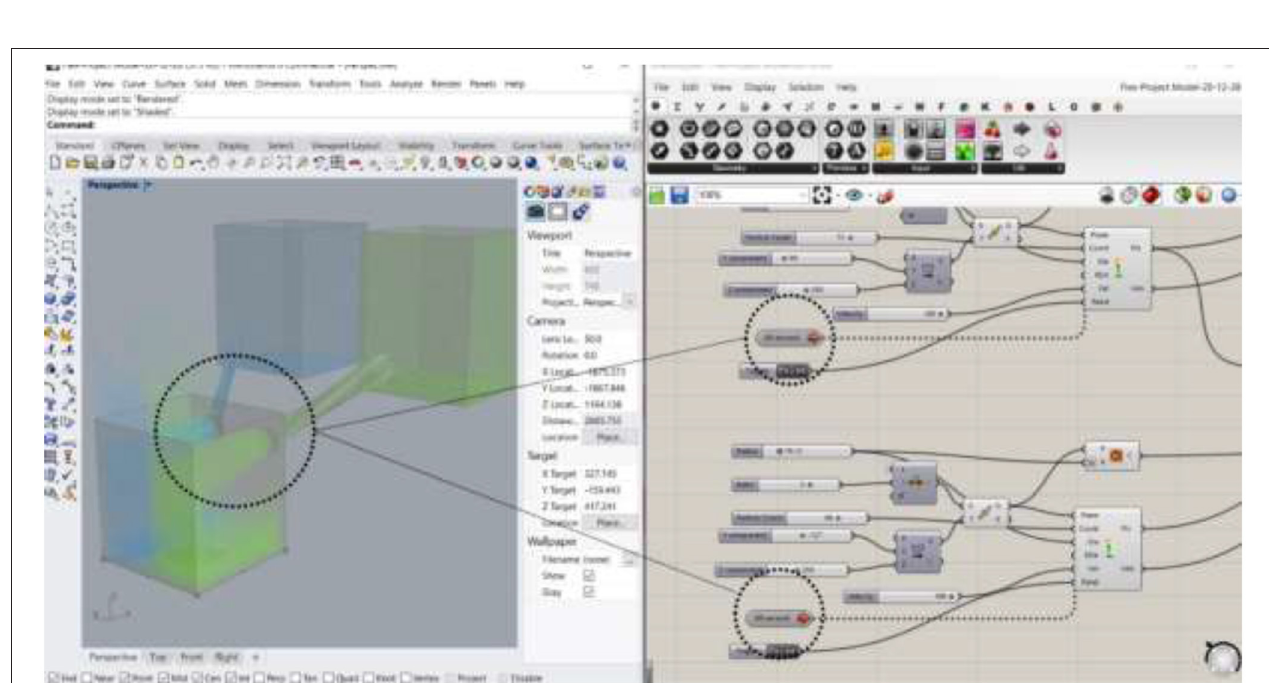
FIGURE 6 | Solenoid valves injection timing control in the virtual environment (writing commands to the bio-computational machine).